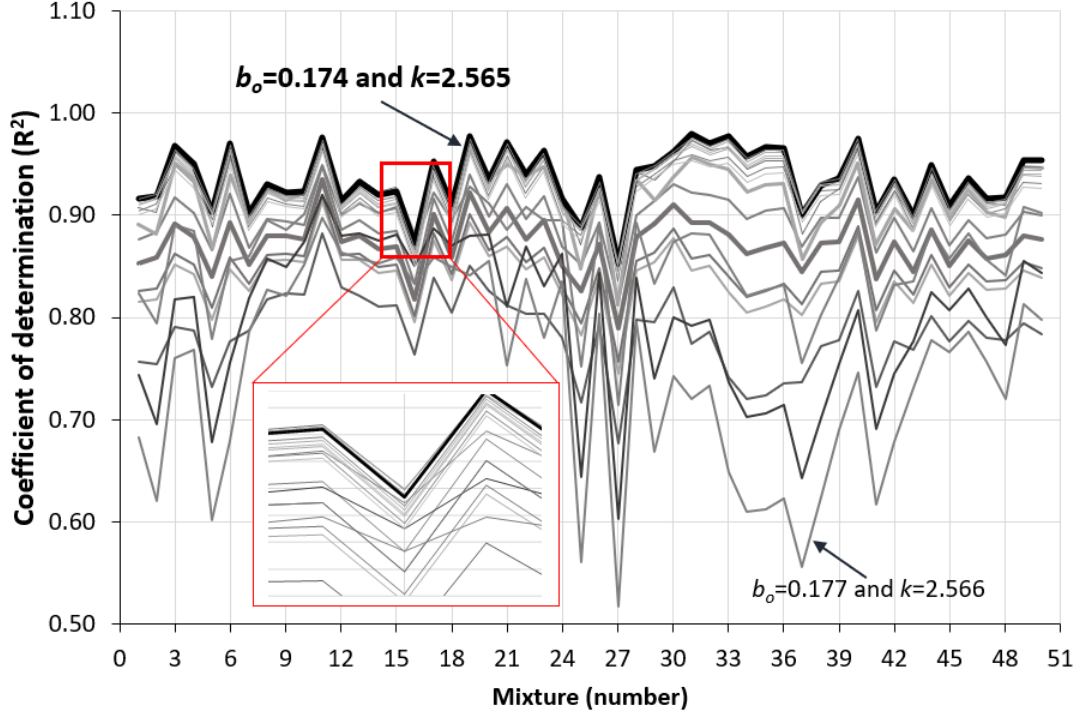
Figure 4. Optimization parameters b o and k for all mixes